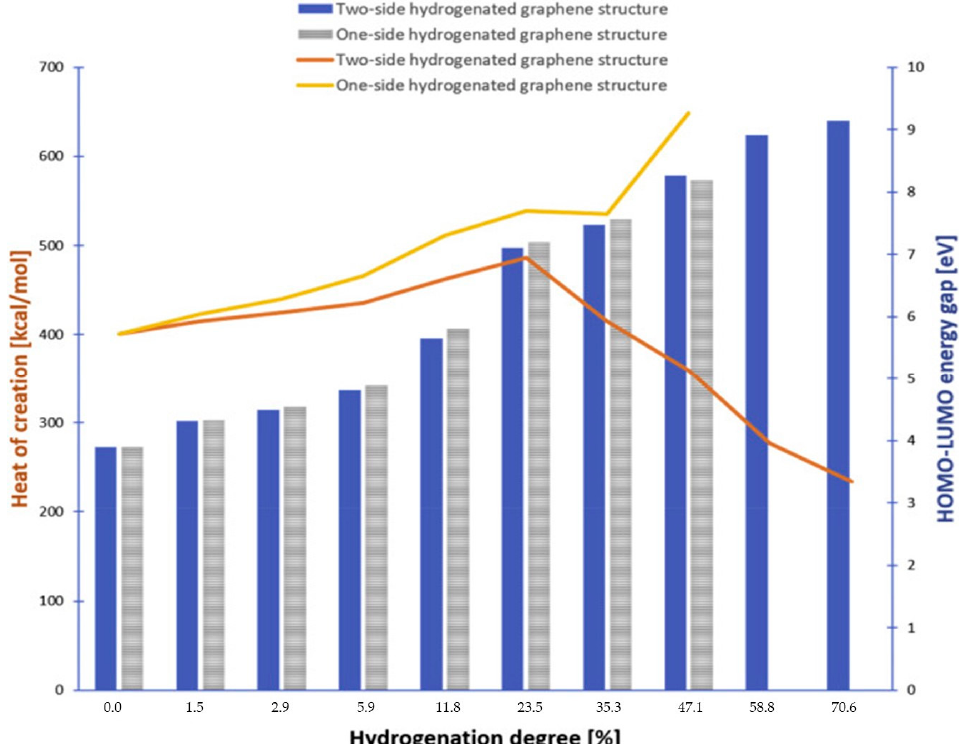
Figure 7. Change in the highest occupied molecular orbital and the lowest unoccupied molecular orbital (HOMO-LUMO) energy gap and the heat of one- or double-sided hydrogenated graphene formation and their hydrogenation degree. Reproduced with permission from Kaczmarek et al., International Journal of Hydrogen Energy; published by Elsevier 2019.